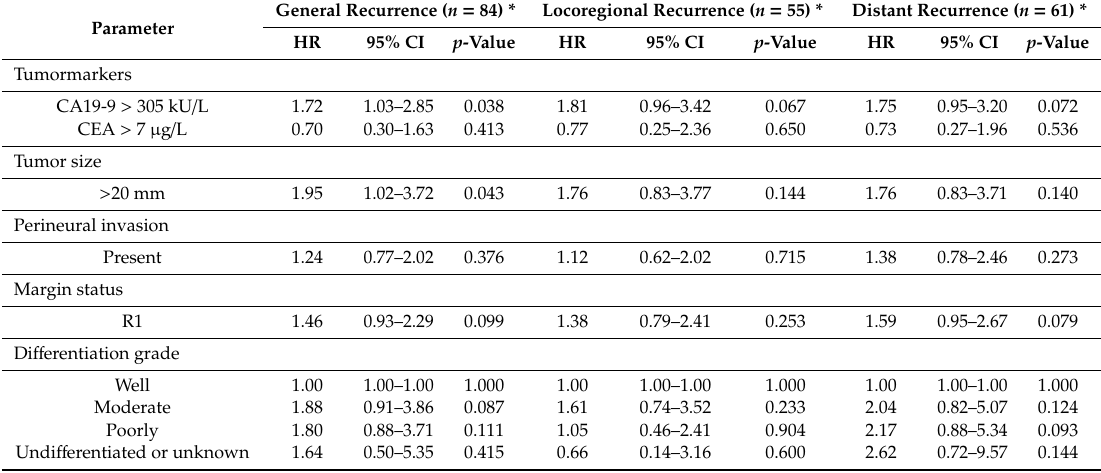
Table 3. Multivariable cox regression analysis for recurrence in resected PDAC